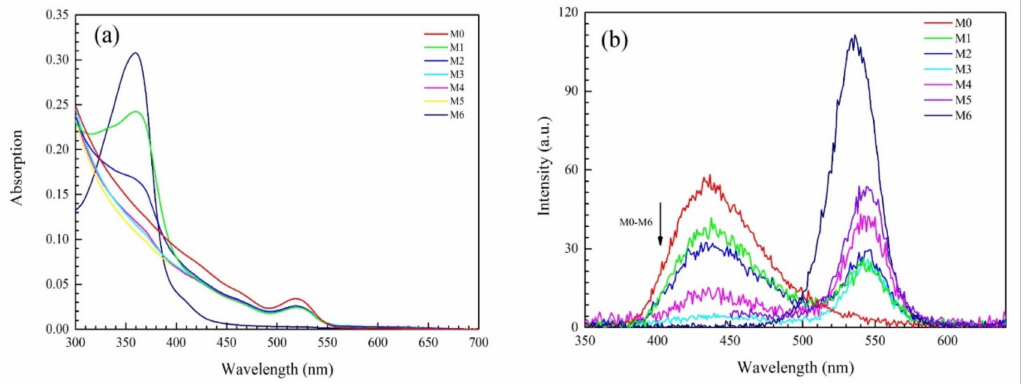
Figure 2. ( a ) Absorption spectra and ( b ) fluorescence spectra ( λ exc. = 405 nm) of AFB1 and CdSe / ZnS QDs mixtures with di ff erent volume ratios in